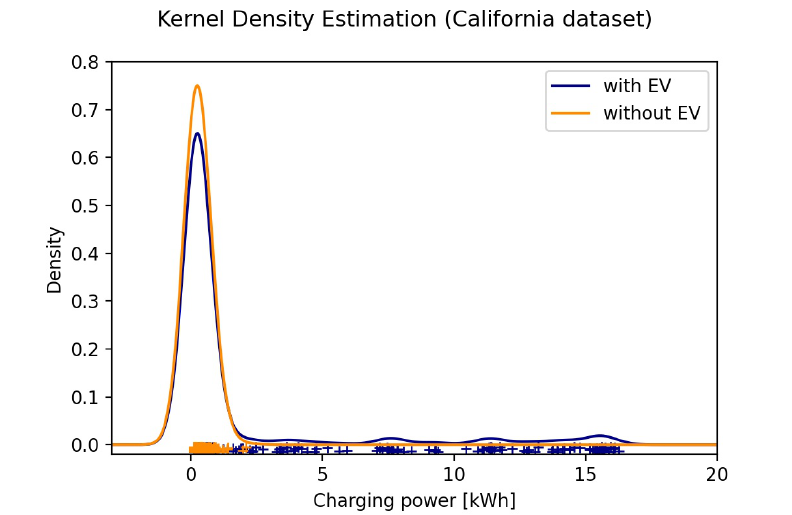
Figure 5. Comparison of kernel density estimates of the synthetic dataset from California with and without EV